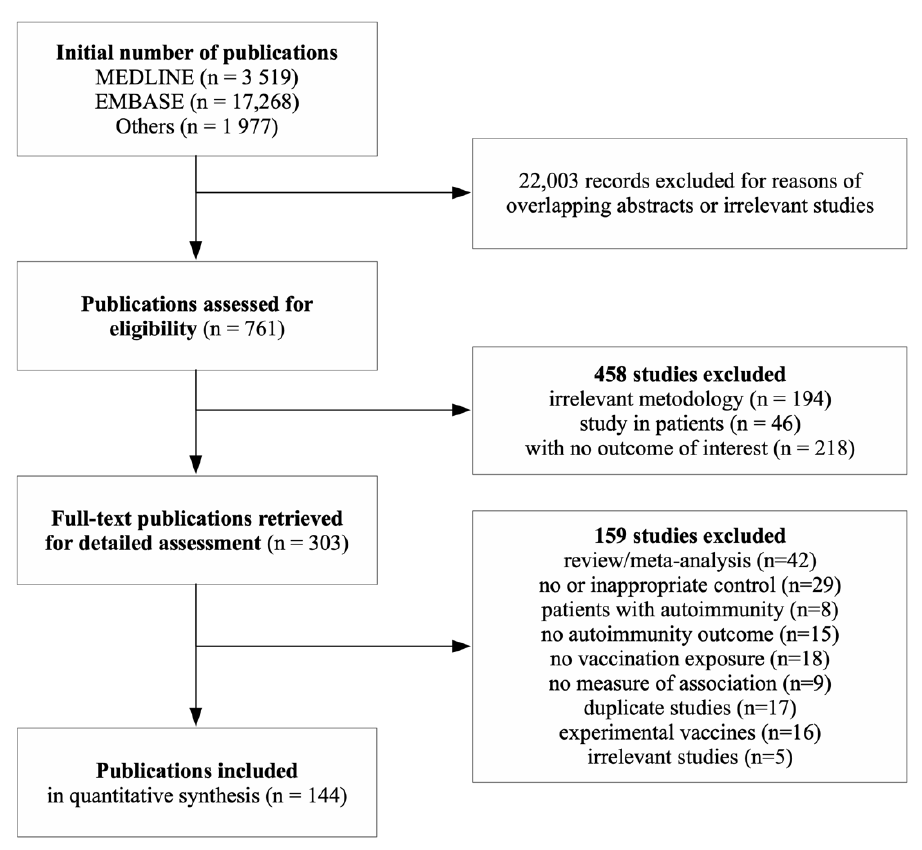
Figure 1. Figure 1. Flowchart.